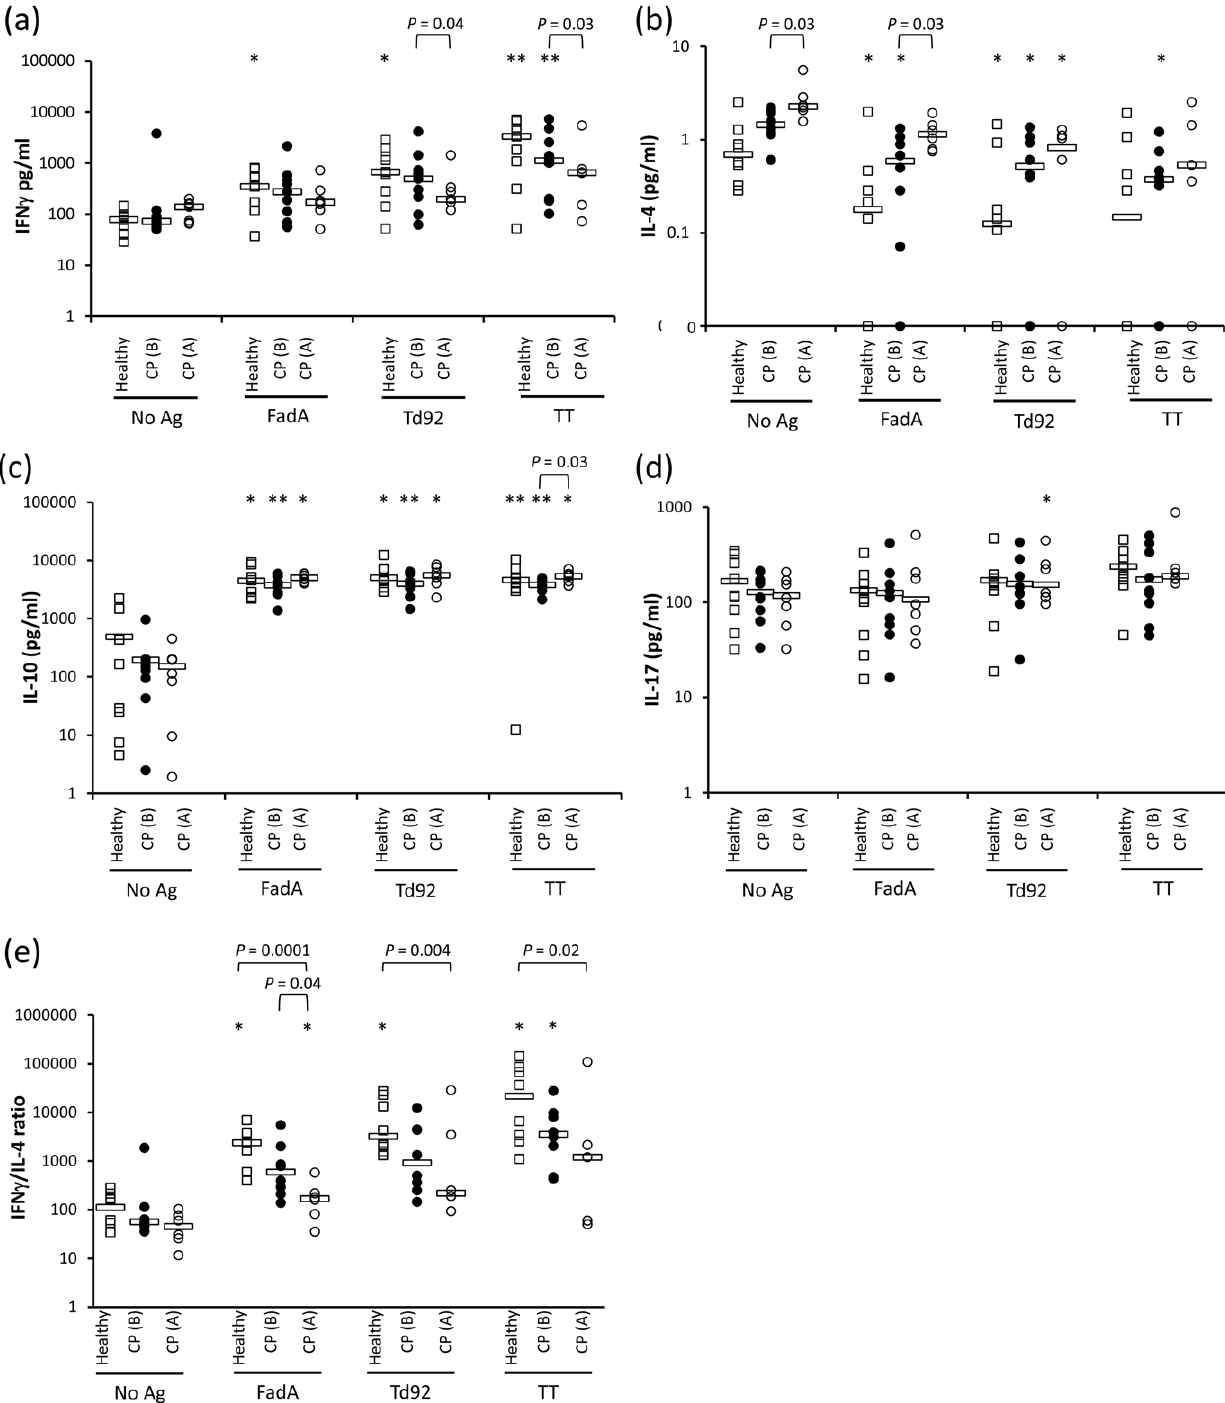
and Td92-specific CD4 + T cells, IgG, and IgA as well as Ag-